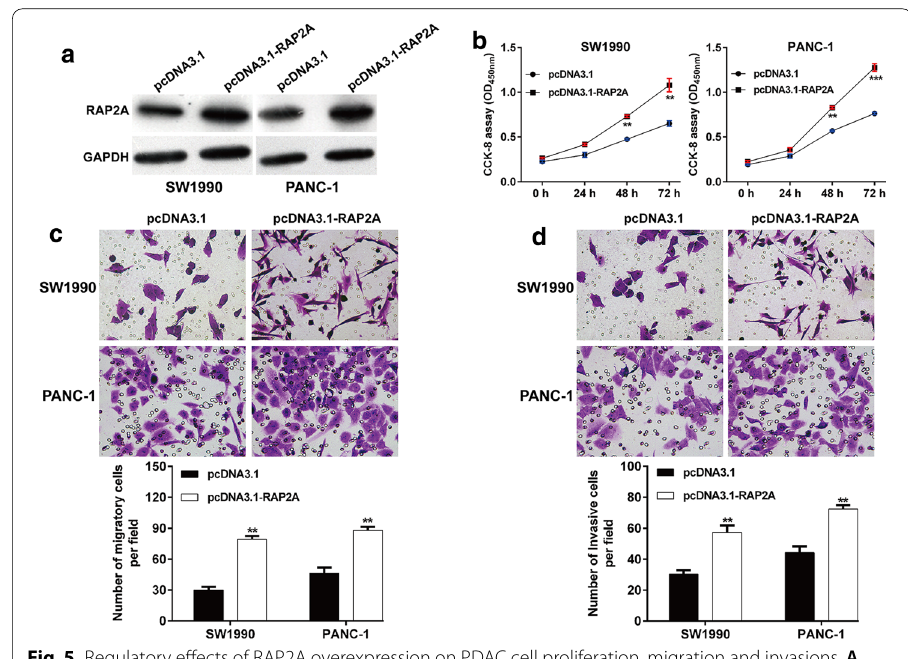
Fig. 5 Regulatory effects of RAP2A overexpression on PDAC cell proliferation, migration and invasions. A Transfection of pcDNA3.1-RAP2A or pcDNA3.1 was performed in SW1990 and PANC-1 cells. After that, the protein expression level of RAP2A was measured by western blot analysis. B Changes in proliferation of transfected SW1990 and PANC-1 cells were evaluated by CCK-8 assay. C , D Cell migration and invasion were analyzed in transfected SW1990 and PANC-1 cells. ** p < 0.01, *** p < 0.001 vs. pcDNA3.1